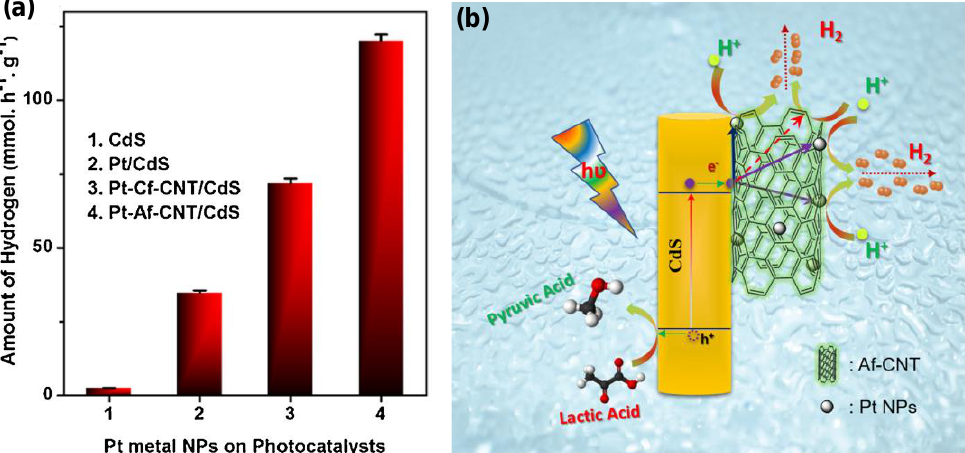
Figure 5. ( a ) Comparison of hydrogen production with Pt nanoparticle-loaded materials versus pure CdS. ( b ) Schematic illustration demonstrating mechanism of H 2 production via photocatalytic water splitting by Pt–Af–CNT / CdS ternary composite. Adapted with permission from Reference [109]. Copyright (2018) Elsevier.